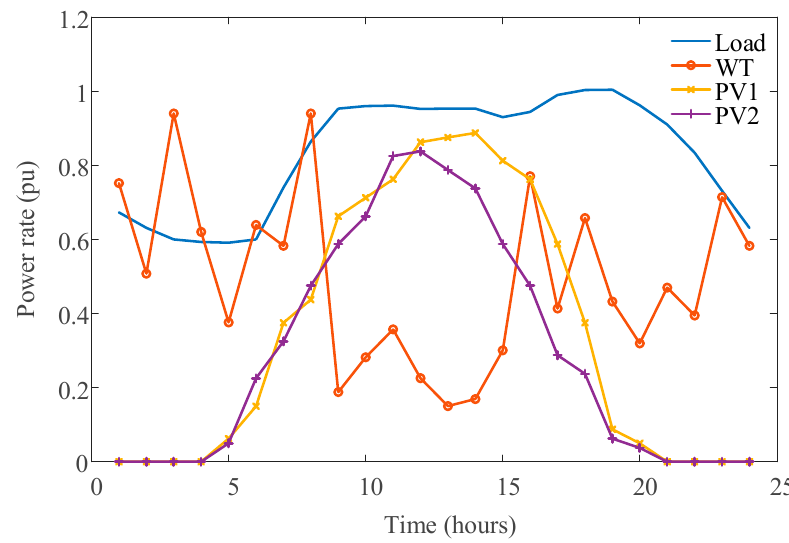
Figure 3. Day-ahead power prediction of the load, wind turbine (WT) and photovoltaics (PVs).